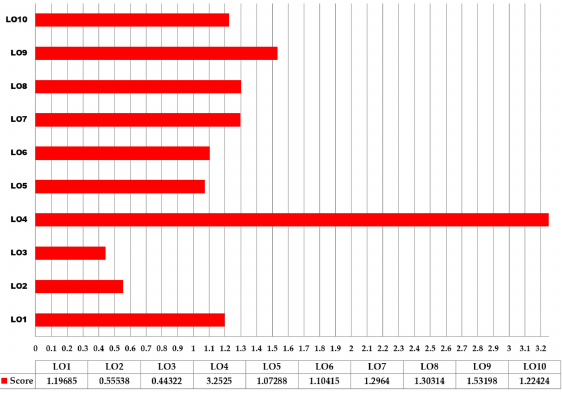
Figure 12. Score efficiency of LOs before alliances (source: